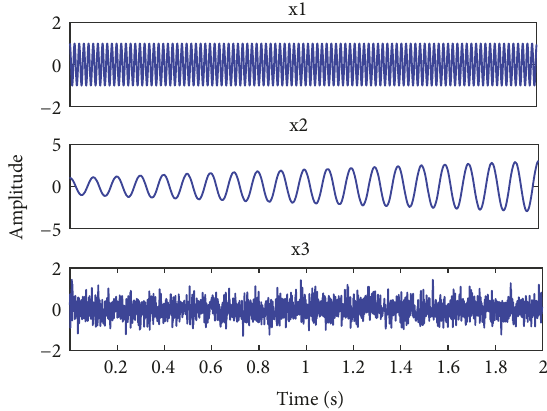
Figure 9: Time-domain waveform diagram of the simulated signal.